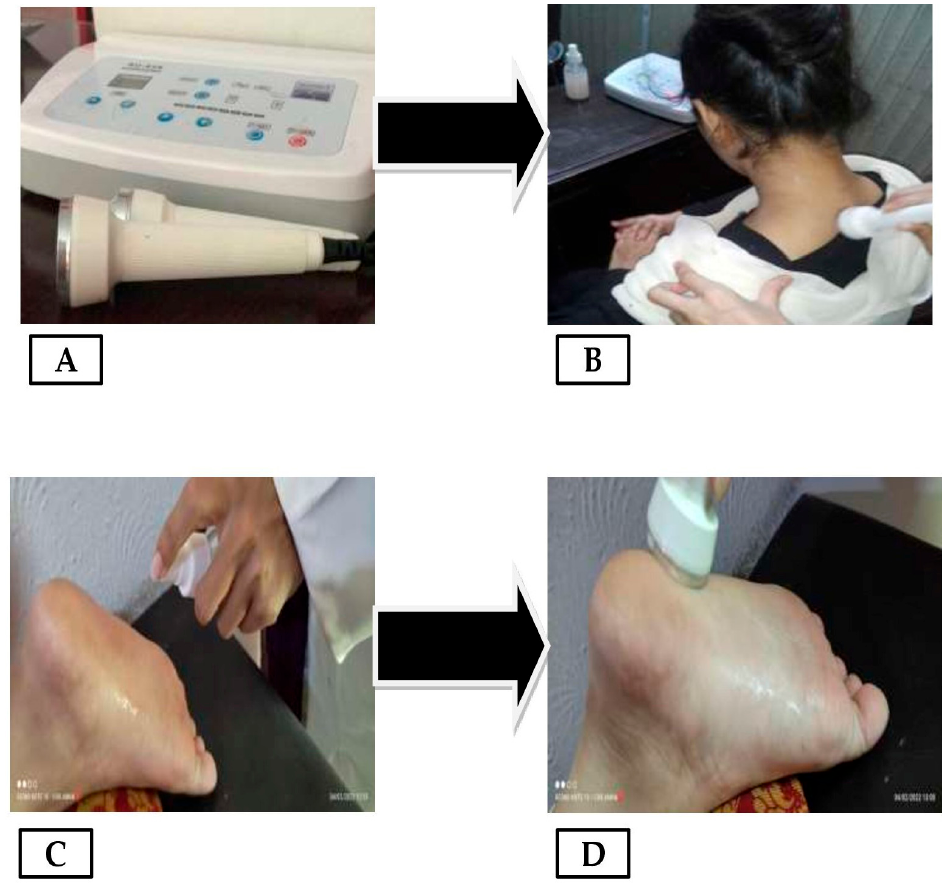
Figure 9. ( A ) Phonophoresis (ultrasound) for the treatment of sport injuries, ( B ) Phonophoresis on a patient with neck pain after applying 4 pumps of DK gel, ( C ) Applying 4 pumps of DK gel on a patient foot, ( D ) Phonophoresis on a patient foot.